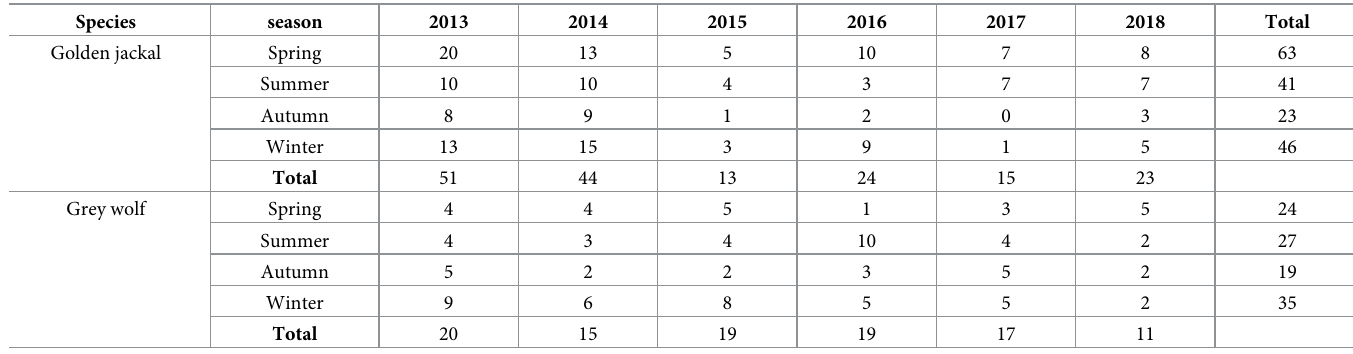
Table 5. Annual distribution of road mortality for the two study species Canis lupus and C . aureus , on the Markazi Province’s main and secondary roads (Iran). Species Golden jackal Spring